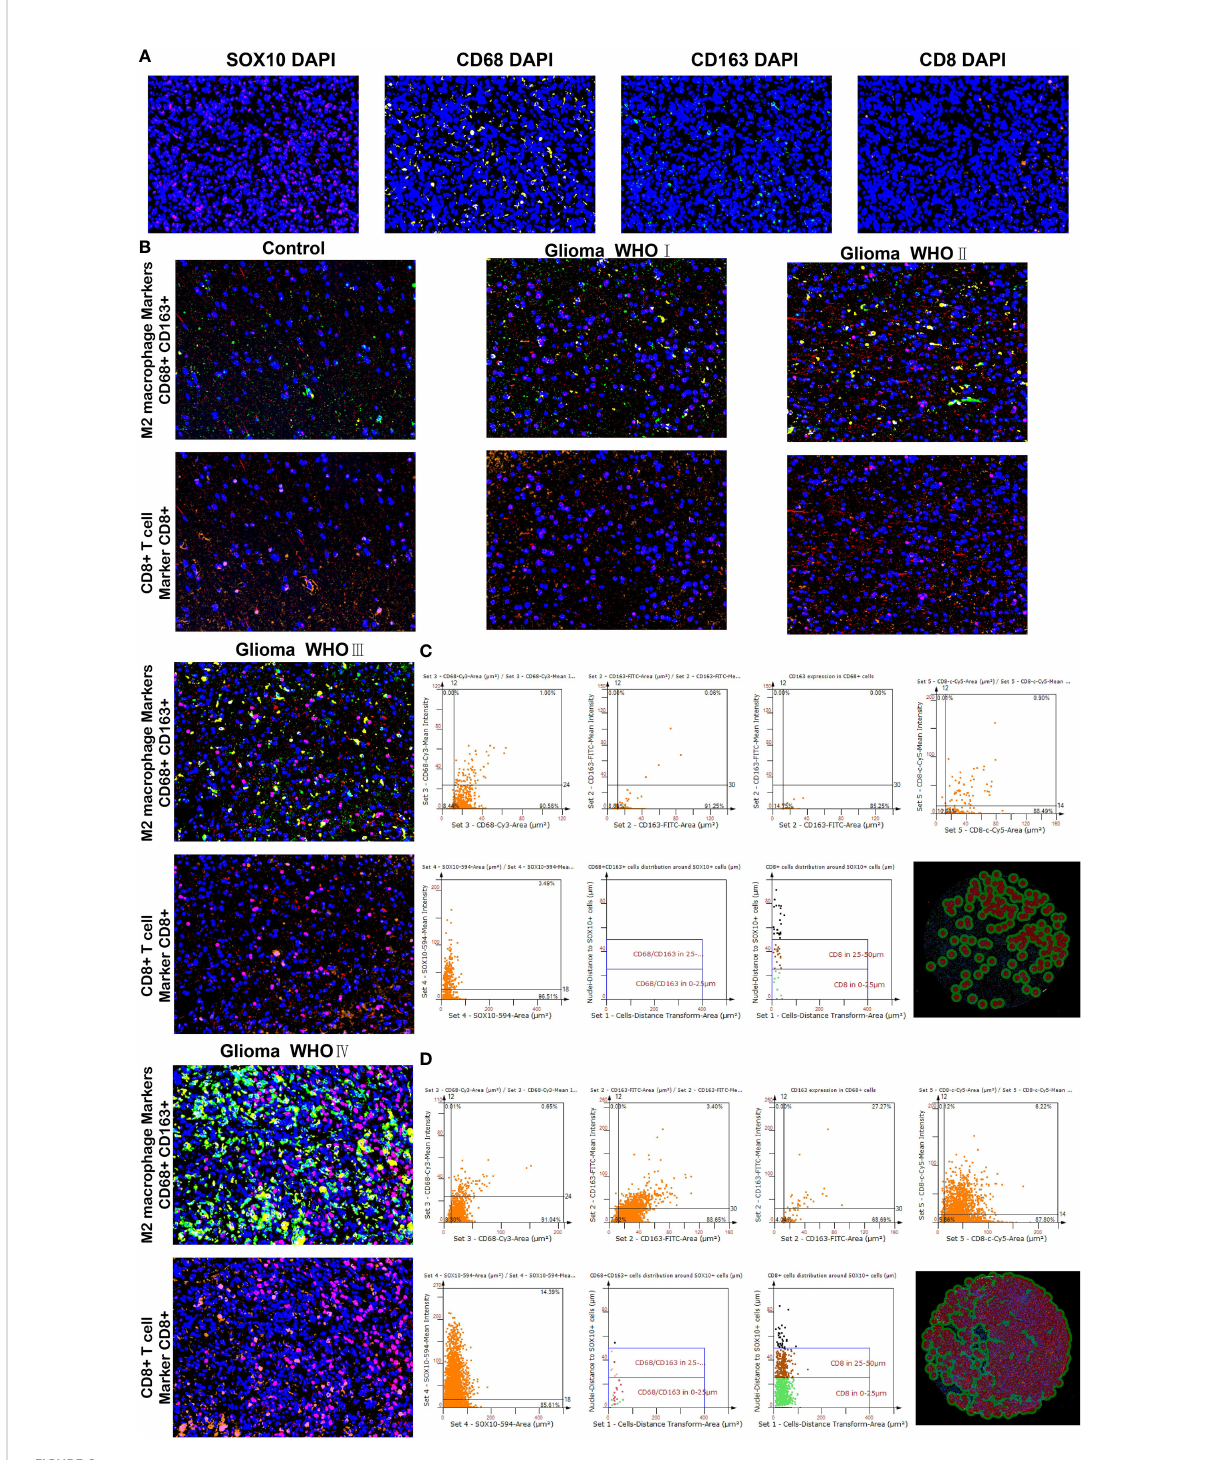
FIGURE 8 Differences in CD68, CD163 macrophages, and CD8 T cells neighboring SOX10-expressed cells. (A) Multiplex immuno fl uorescence staining of SOX10 (pink), CD68 macrophages (yellow), CD163 macrophages (green), CD8 T cells (orange), and DAPI (blue). (B) Multiplex immuno fl uorescence images of M2 macrophage markers CD68+ and CD163+, and CD8+ T cell marker CD8+ in control, Glioma WHO I, Glioma WHO II, Glioma WHO III, and Glioma WHO IV groups, respectively. The scatter diagrams display the quantity of CD68+ cells, CD163+ cells, CD68+CD163+ cells, CD8+ cells, and SOX10 expressed cells and the quantity of CD68 ⁺ CD163 ⁺ cells along with CD8+ cells at different locations neighboring SOX10 expressed cells at 0 – 25 and 25 – 50 m m. Images of automatically identi fi ed staining by the TissueFAXS and StrataQuest software in (C) Glioma WHO III group and (D) Glioma WHO IV